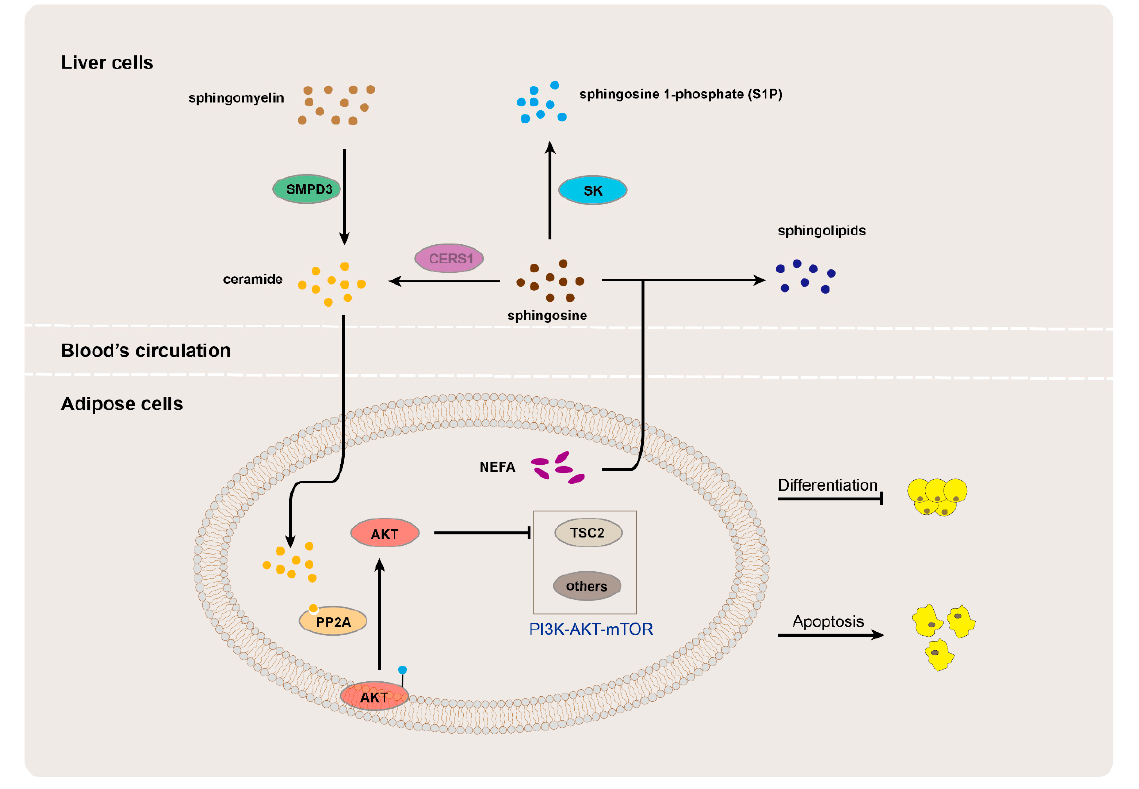
Figure 4. Correlation and pathway analysis of the DEGs and DEMs. The ceramide metabolic process was assigned with four central DEGs and DEMs of the KEGG-rich pathway.